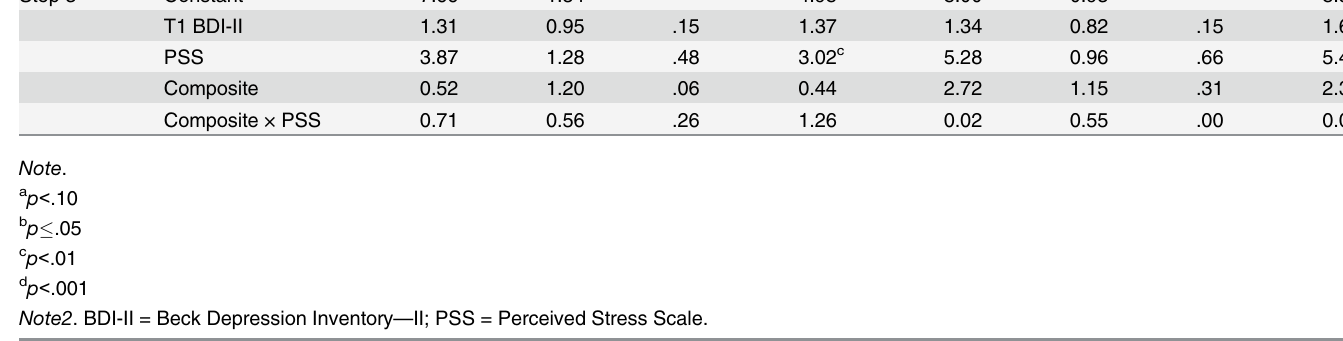
adding the weakest link composite in step 3 significantly added to the model including T1 BDI-II, PSS, and the additive composite, Δ R 2 = 6.2%, Δ F (1,47) = 11.39, p < .01. Of the variables in step 3, PSS ( β = .66, p < .001) and the weakest link composite ( β = .37, p < .01), but neither T1 BDI-II ( β = .18, p = .08) nor the additive composite ( β = -.09, p = .44) predicted T2 BDI-II. Potential confounds